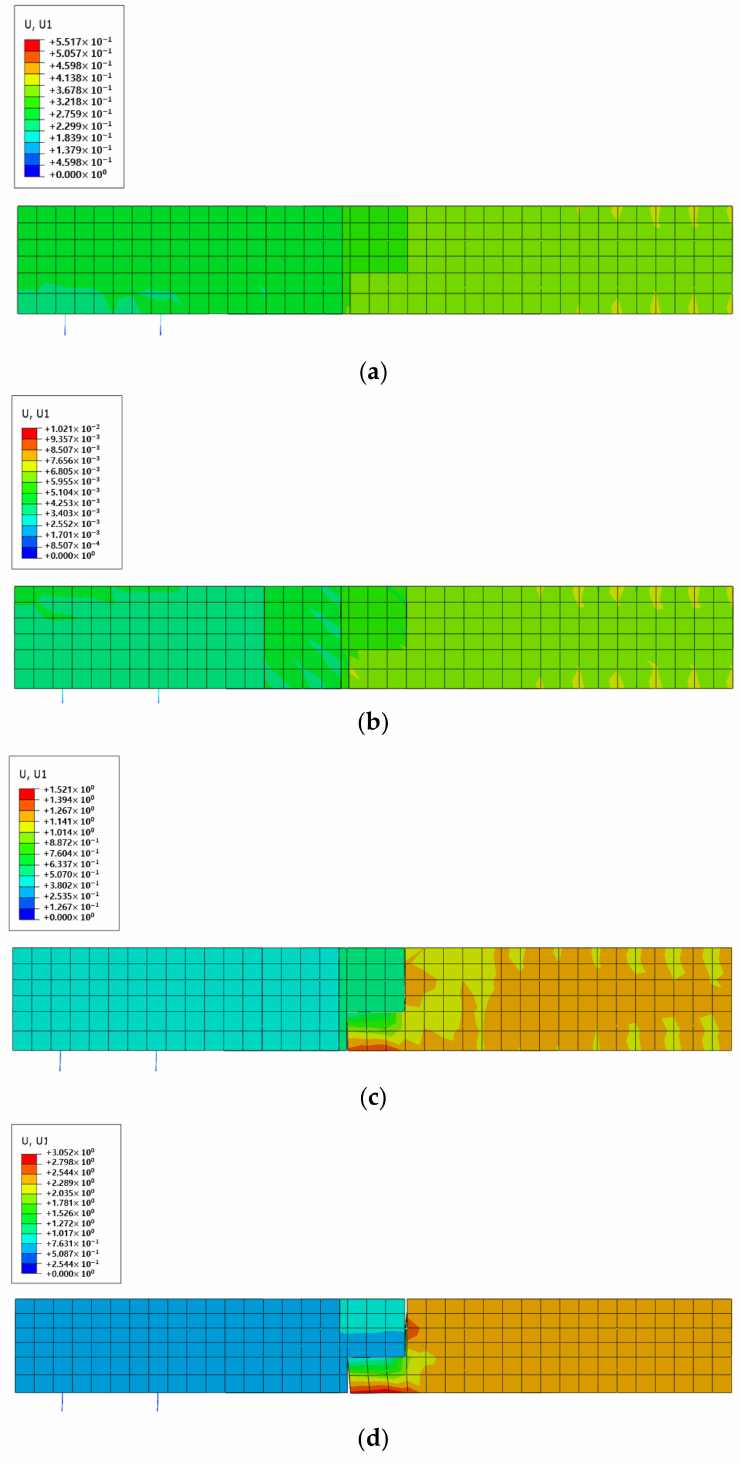
Figure 13. Displacement distribution in the FEM of J100-HB-SP: ( a ) 482 kN (initial cracking); ( b ) 600 kN (extensive cracking); ( c ) 750 kN (accelerated cracking); ( d ) 840 kN (final